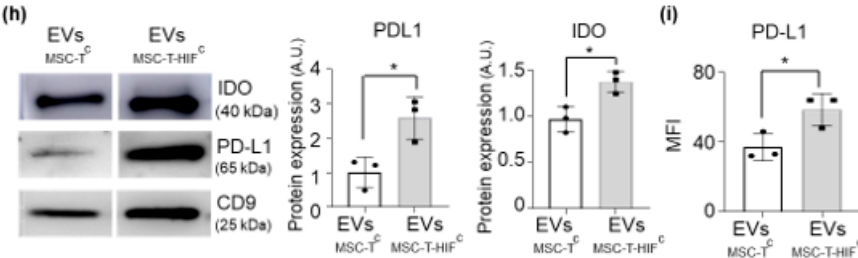
Figure 4. MSC-T-HIF c -derived EVs (EV MSC-T-HIFc ) display enhanced immunosuppression properties. ( a ) Representative images of EVs collected from MSC-T-HIFc evaluated by nanoparticle tracking analysis (NTA). ( b ) Representative electron microscopy images of isolated EVs collected from MSC-T-HIFc. Scale bar: 200 nm. ( c ) Representative Western blots of Hsp70, TSG101 and CD9 proteins in EVs. Absence of calnexin demonstrates a pure EV preparation. Cells were used as calnexin-positive controls ( d ) Concentration of protein of EVs extracted from 100 mL of culture medium from 1 × 10 7 cells that were resuspended in 100 μ L of PBS. Graphs represent mean ± SD of six independent experiments. Paired t -test was used for statistics. ( e ) Quantification of acetylcholinesterase activity in EV MSC-Tc and EV MSC-T-HIFc . Values are represented as relative to the EV MSC-Tc value. Graph represents mean ± SD of three independent experiments. Paired t -test was used for statistics. ( f ) Amount of EVs per milliliter in the supernatant of the same number of MSC-Tc and MSC-T-HIFc measured by NTA. Graphs represent mean ± SD of three independent experiments. Unpaired t -test was used for statistics. ( g ) Peripheral blood mononuclear cells (PBMCs) were stained with CFSE and stimulated with anti-CD3 and anti-CD28 beads in the presence or absence of EV MSC-Tc or EV MSC-T-HIFc . After 6 days, cells were stained with anti-CD3, anti-CD4 and anti-CD8 antibodies and the proliferation of T-cell subsets was determined by flow cytometry of CFSE dilution. Suppression (percentage) was calculated based on the expansion index. Graph represents mean ± SD of seven independent experiments. Unpaired t -test was used for statistics. ( h ) Representative Western blots of IDO and PD-L1 proteins in EV MSC-Tc and EV MSC-T-HIFc . Expression levels were quantified by densitometry relative to EV MSC-Tc . CD9 was used as a loading control. Graph represents mean ± SD of three independent experiments. Paired t -test was used for statistics. ( i ) PD-L1 protein expression level measured by flow cytometry using the mean fluorescence intensity of EV MSC-Tc and EV MSC-T-HIFc . Values are represented as relative to the EV MSC-Tc geometric mean value. Graphs represent mean ± SD of three independent experiments. Paired t -test was used for statistics. * p < 0.05, ** p <